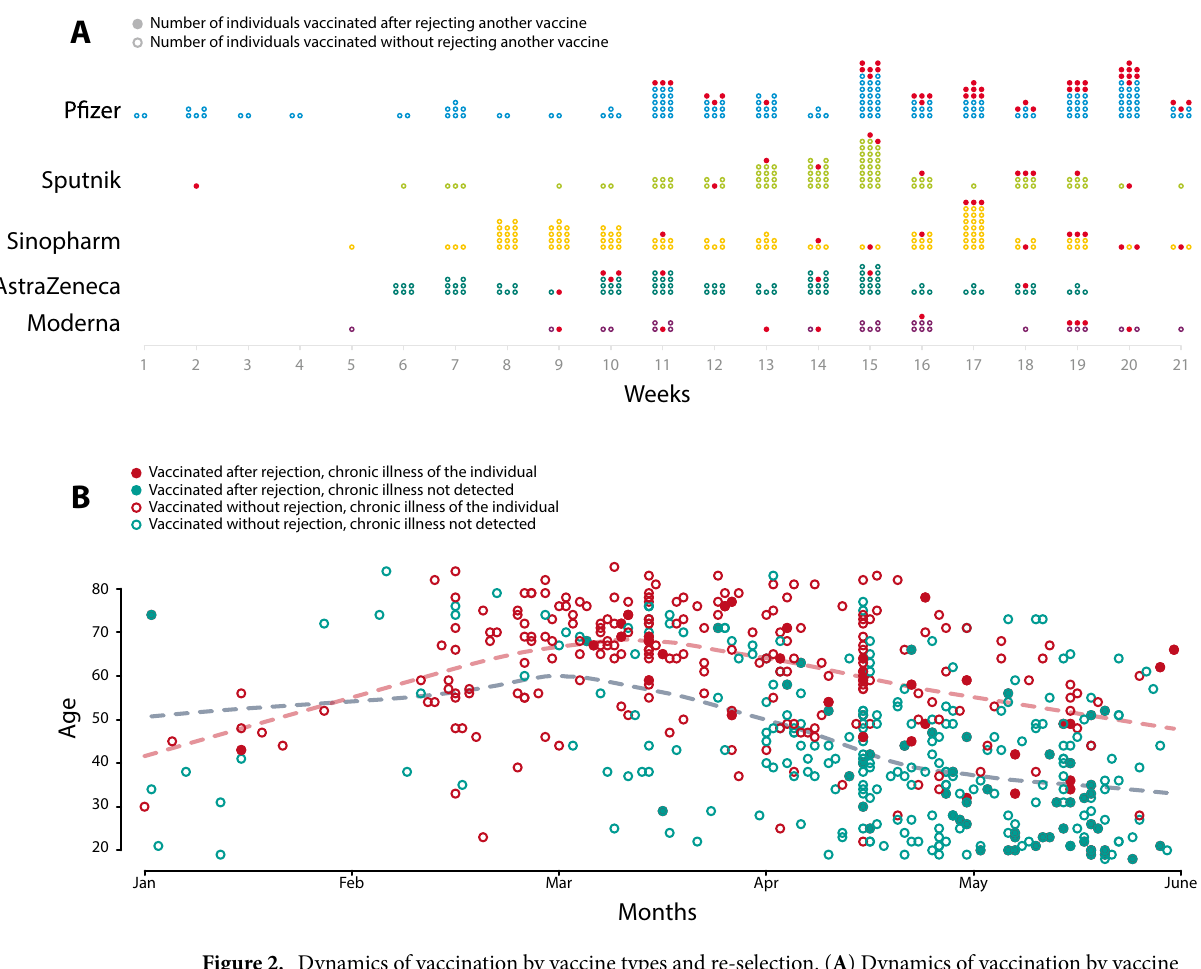
Figure 2. Dynamics of vaccination by vaccine types and re-selection. ( A ) Dynamics of vaccination by vaccine types. Dots represent the taken vaccine by weeks in 2021. Dark dots represent the vaccines that were accepted after rejecting another one. ( B ) The dynamics of vaccination by age and chronic illness. We used red circles for the chronically ill patients and green circles for the healthy individuals to show the day of receiving the first vaccine. Filled markers denote the individuals who rejected at least one vaccine earlier. Dashed lines represent the local averages of vaccinated patients’